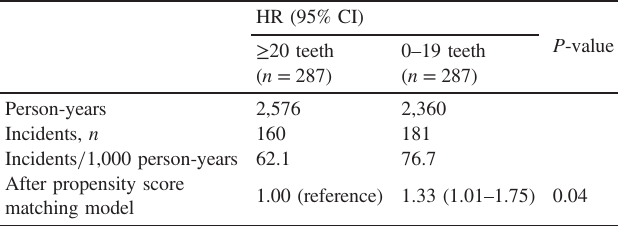
Table 2. The relationship between the number of remaining teeth and the incidence of functional disability (Cox propor- tional hazards model after propensity score